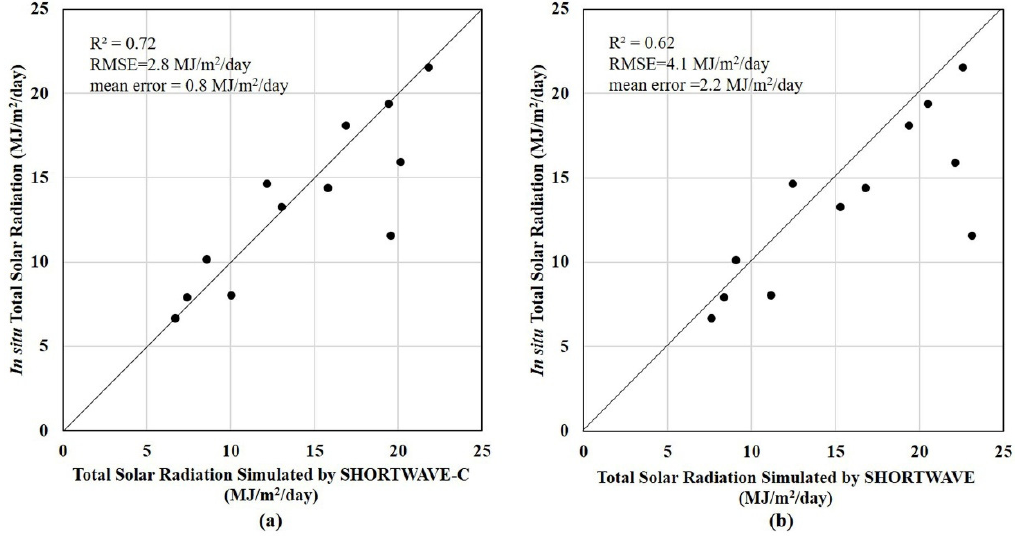
Figure 6. Comparison of in situ monthly total solar radiation and simulated monthly total solar radiation from December 2012 to November 2013. ( a ) Comparison with total solar radiation simulated by SHORTWAVE-C; ( b ) Comparison with total solar radiation simulated by SHORTWAVE.